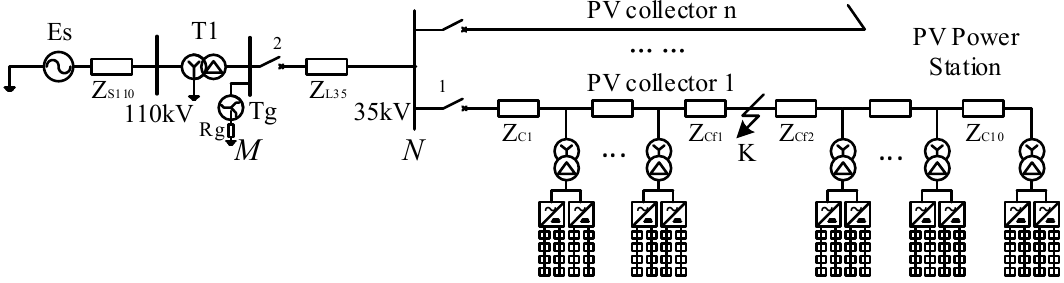
Figure 4. Equivalent circuit for the fault on the collector line.